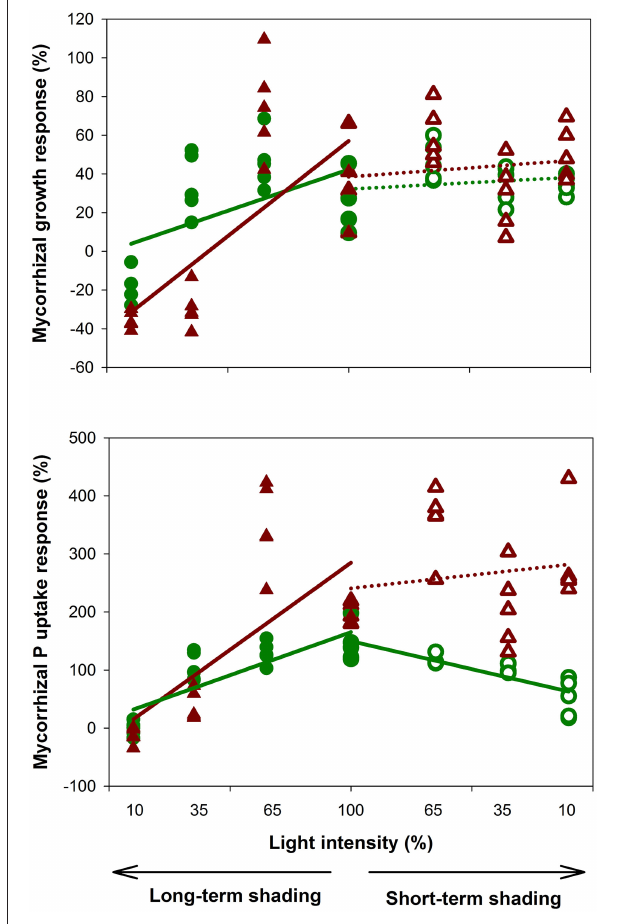
FIGURE 1 | Growth and phosphorus uptake responses of Medicago truncatula plants subjected to experimental shading—either long-term (38 days, closed symbols) or short term (6 days, open symbols) shading, with four different light intensities each. Five replicate values for shoots (green circles) and roots (brown triangles) per light treatment are shown, together with the linear regression lines testing consistency of the observed effects along the shading gradients (separately for the short- and long-term shading and for the roots and shoots). Mycorrhizal responses were calculated as 100 × (AM-NM)/NM, where AM is the shoot or root dry weight of mycorrhizal plant and NM is the mean value of the respective non-mycorrhizal control treatment ( N = 5). Solid lines indicate significant trends ( p < 0.05), whereas dotted lines show lack of statistical significance along the shading